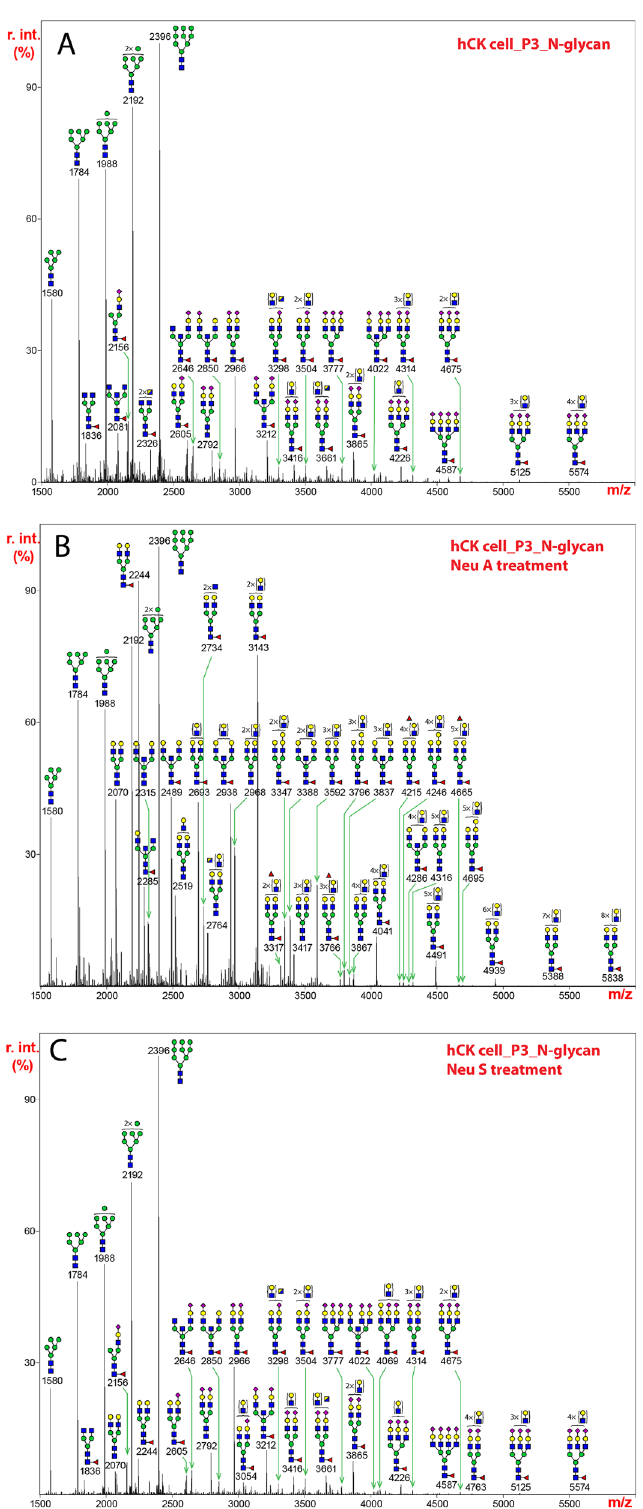
Figure 3. N-glycans released from extracts of hCK cells by treatment with PNGase F, permethylated, and analyzed by MALDI-TOF MS. The medial molecular range between m/z 1500 and 5500 is shown. Putative structures based on compositions and corresponding to masses detected are represented next to the corresponding mass peaks. ( A ) N-glycans from hCK cells at passage 3. ( B ) N-glycans in ( A ) from extracts of hCK cells at passage 3 were treated with neuraminidase A and analyzed. ( C ) N-glycans in ( A ) from extracts of hCK cells at passage 3 were treated with neuraminidase S and analyzed. The assignments of N-glycan mass and compositions, as well as relative percentage abundance of each glycan species in ( A ), ( B ), and ( C ) are presented in Supplementary Table